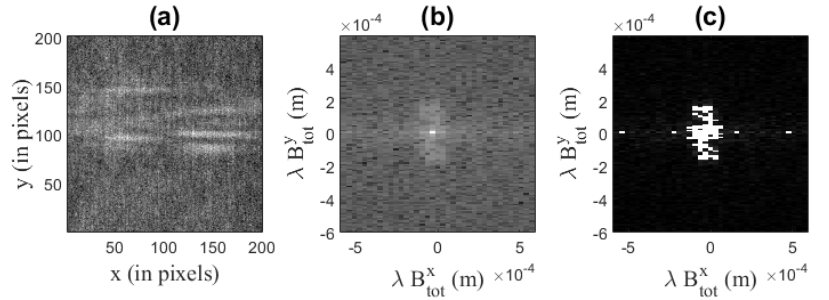
Figure 10. Section of the interferometric image of particle 2 (in green in Figure 7) that will be 2D Fourier-transformed ( a ), the log of its 2D Fourier transform ( b ), and its binarization ( c ). For particle 3 (encircled in white in Figure 7), the truncated pattern, its scaled 2D Fourier transform in the logarithmic scale, and its binarization are presented in Figure 11a–c, respectively. The dimensions of the particle can be estimated to be 140 × 170 μm .